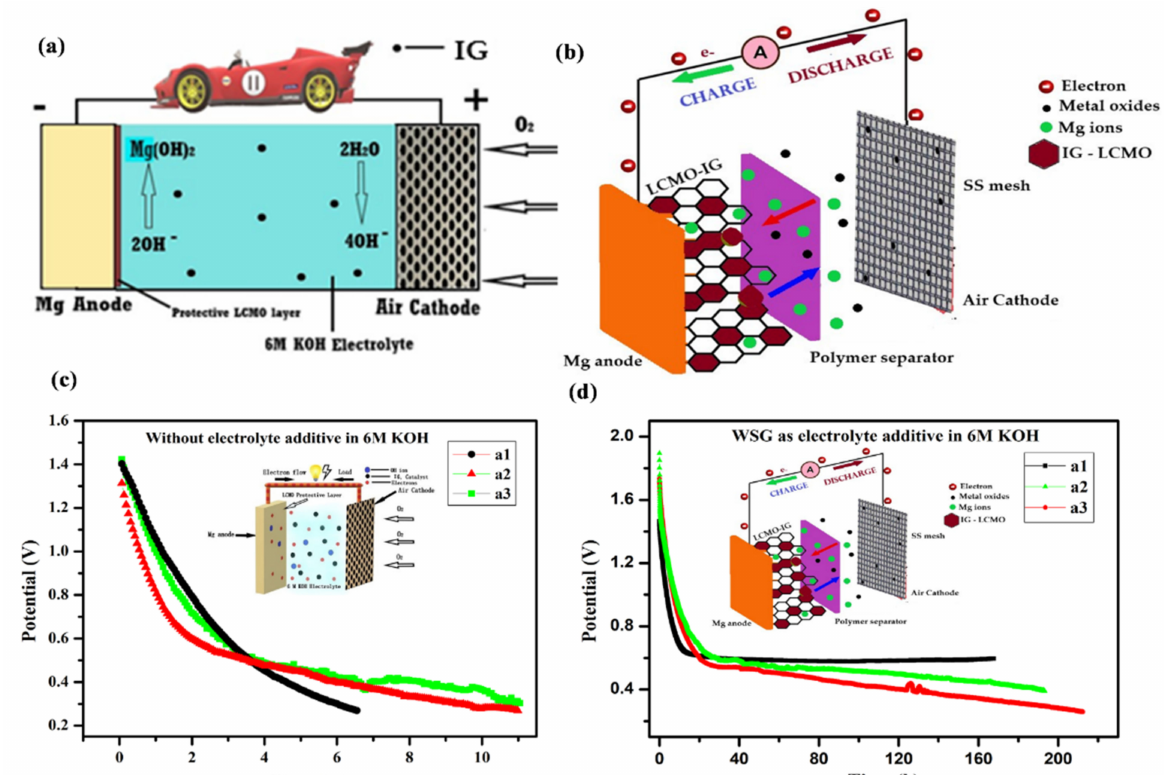
Figure 33. ( a ) Construction of Mg-air battery ( b ) Mechanism behind the operation of the Mg-air battery ( c , d ) Discharge performance of lanthanum-based electrodes for Mg–air batteries in 6M KOH and WSG-6M KOH (adapted with permission from [472]. Electrochem Soc.,